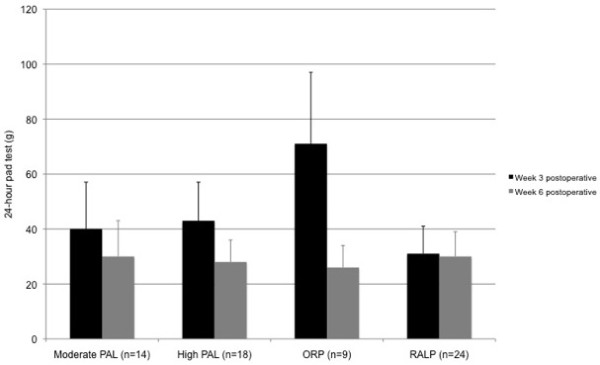
24-hour pad test outcomes at 3 and 6 weeks postoperatively, separated by preoperative physical activity category (moderate vs high physical activity level (PAL), using Armband data from week before surgery) and surgical group (mean + SE).